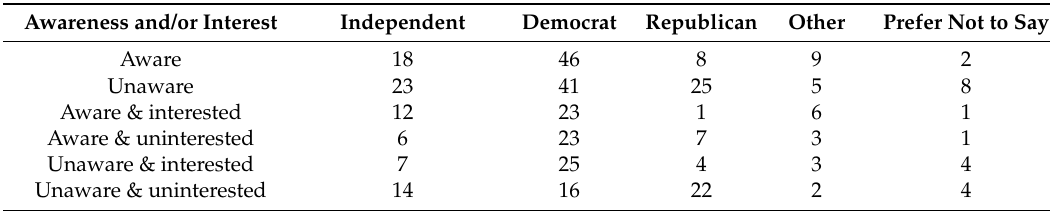
Table 3. Political Party and interest and